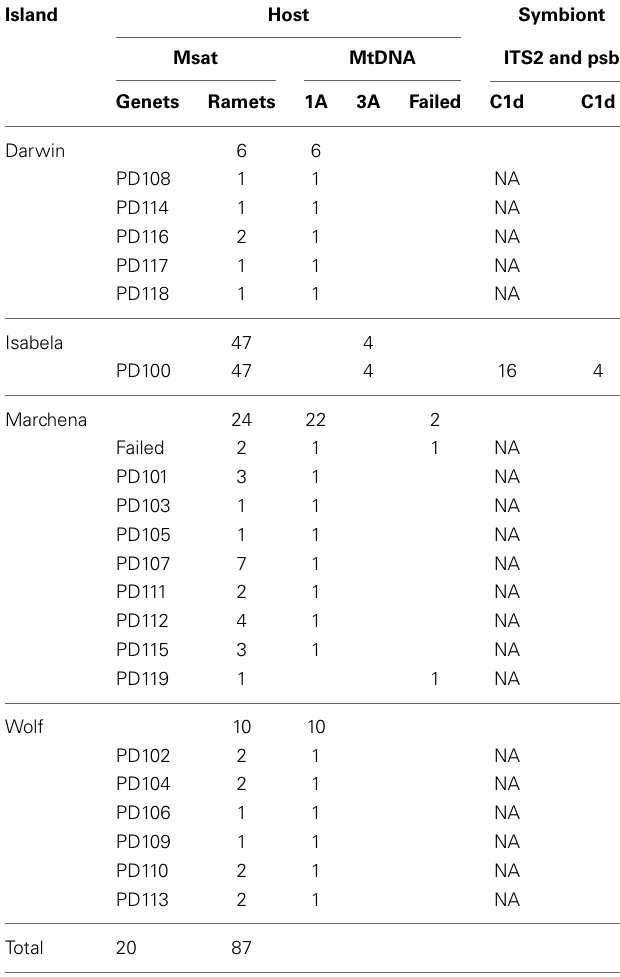
Table 1 | Pocillopora colonies collected at Darwin, Isabela, Marchena and Wolf Islands, Galápagos Islands.